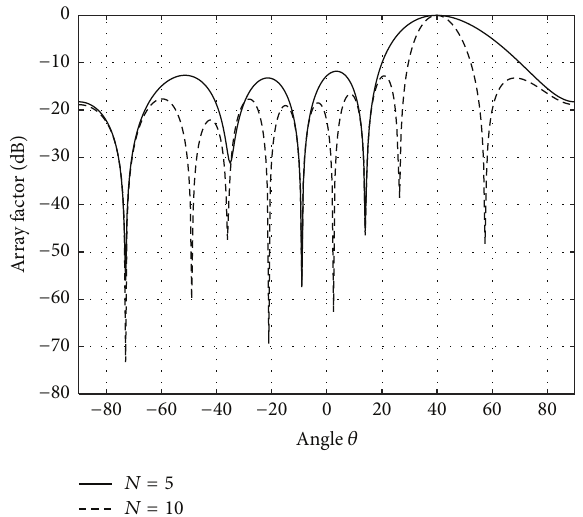
Figure 10: Comparison of the antenna arrays radiation pattern with 𝑁 = 10 and 𝑁 = 5 elements: the angle of arrival of the desired signal is 40 ∘ and the angle of arrival of the interfering signal is − 35 ∘ ; SNR = 5